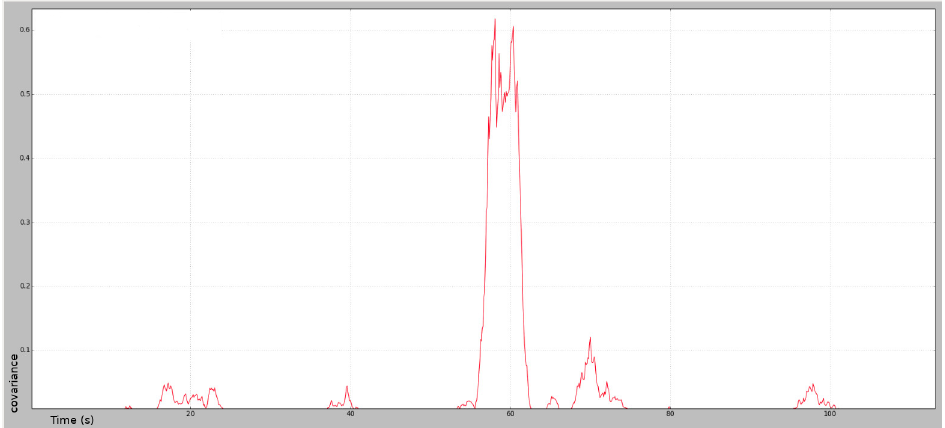
Figure 10. Evolution of the covariance as a comparison between odometric data and Doppler data over time. The X-axis is time in seconds, the Y-axis is